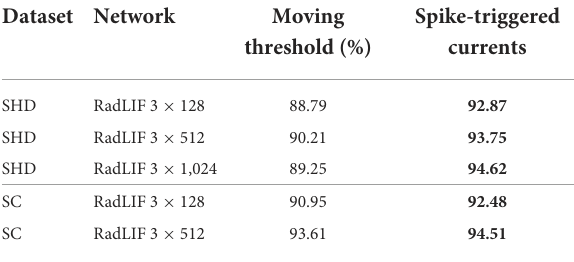
TABLE 11 Comparison between our adaptation scheme and an alternative moving threshold on the SHD and SC datasets. Dataset